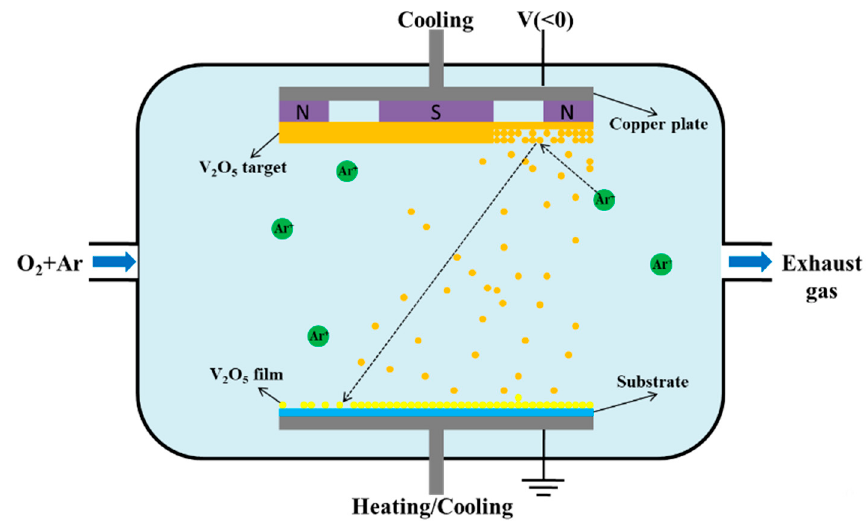
Figure 1. Schematic diagram of preparation of V 2 O 5 films by magnetron sputtering.